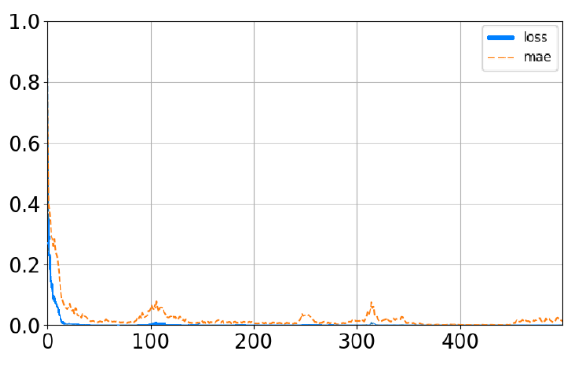
Figure 10. Python Figure 10. Python results.